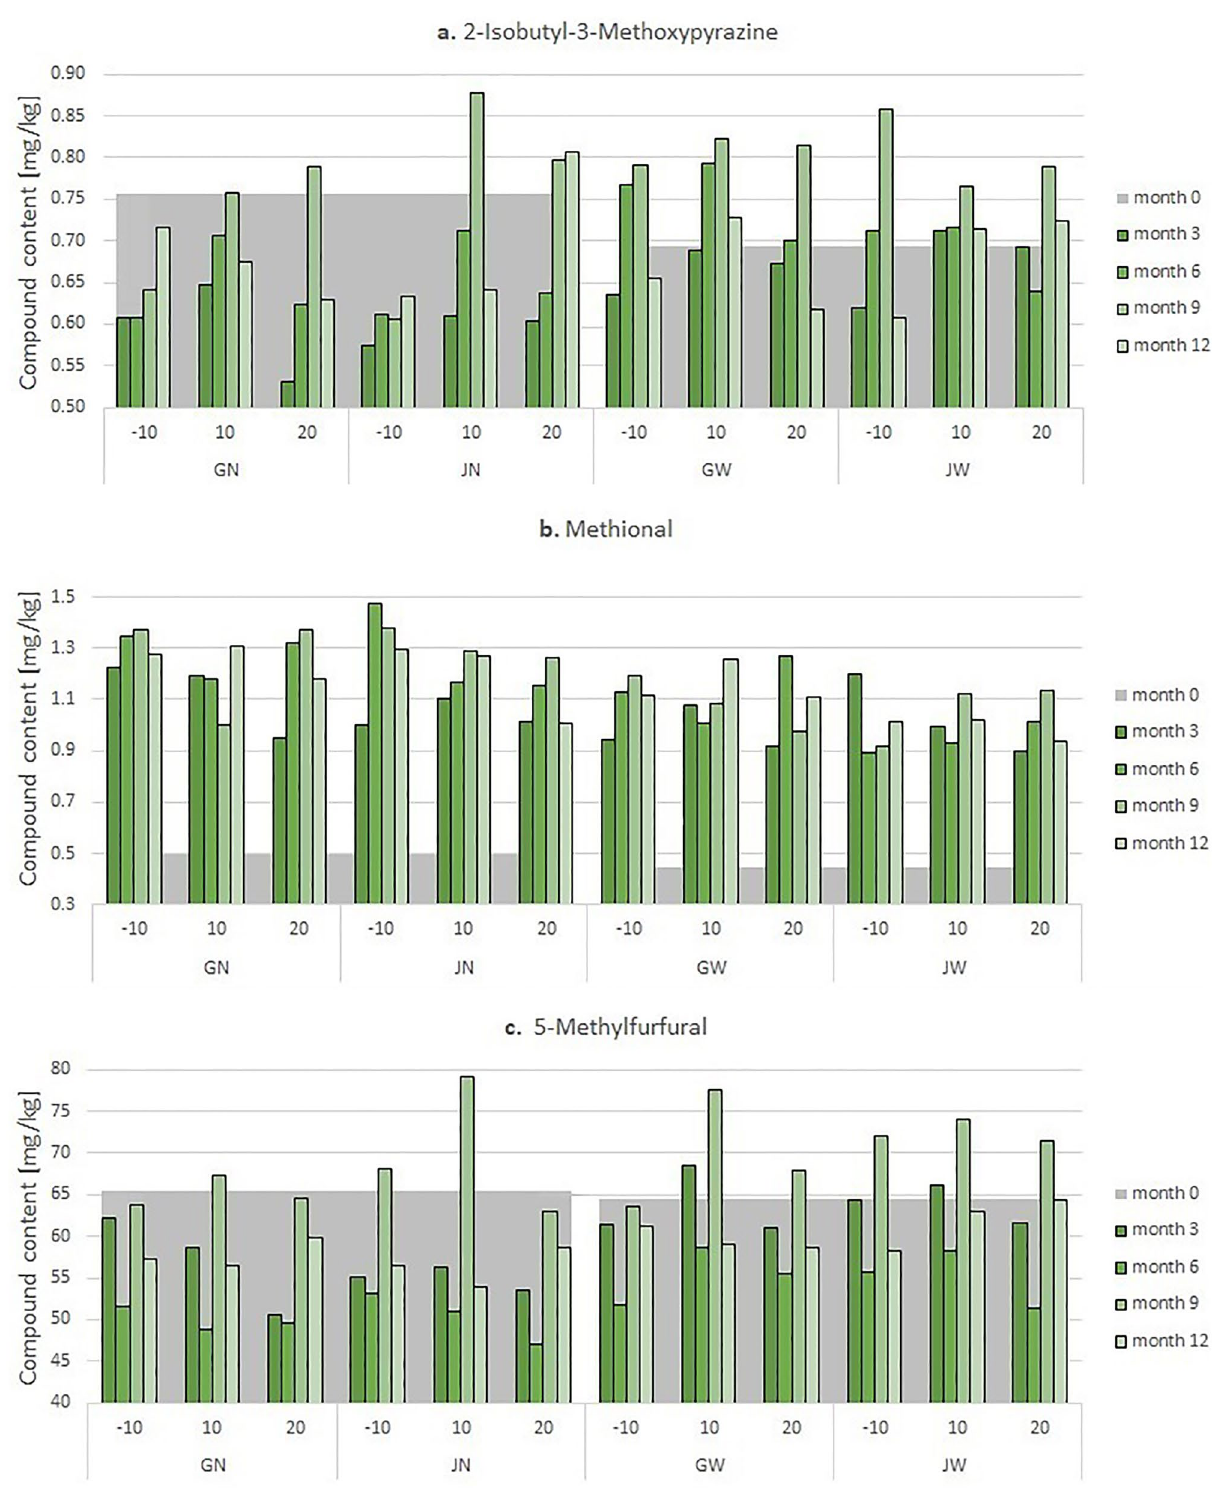
Figure 3. Graph of changes of 2-Isopropyl-3-Methoxypyrazine content of 2-Isobutyl-3-Methoxypyrazine in tested roasted coffee samples on a 12-month basis (with results recorded every 3 months), after appropriate treatment in